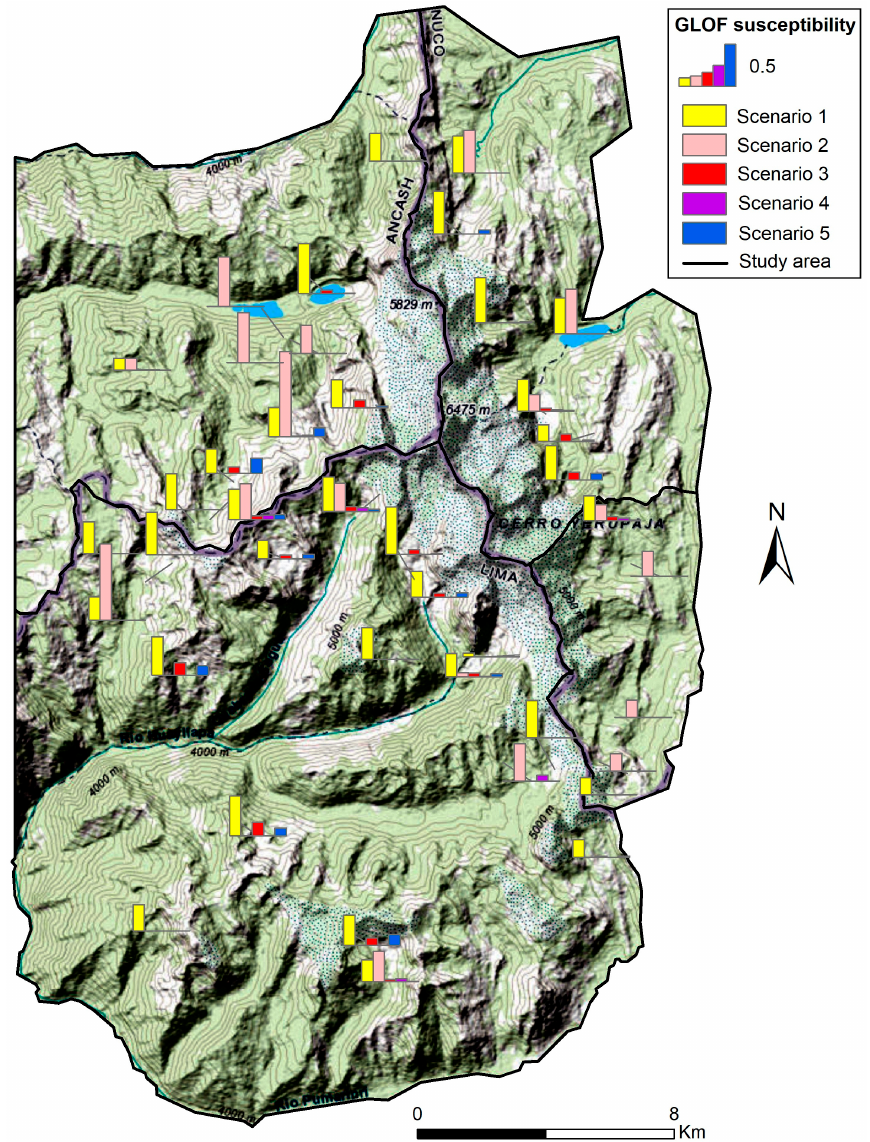
Figure 6. Map of the GLOF susceptibility of 46 large lakes (>20,000 m 2 ) of the Cordillera Huayhuash. Background map: Background map: [40].